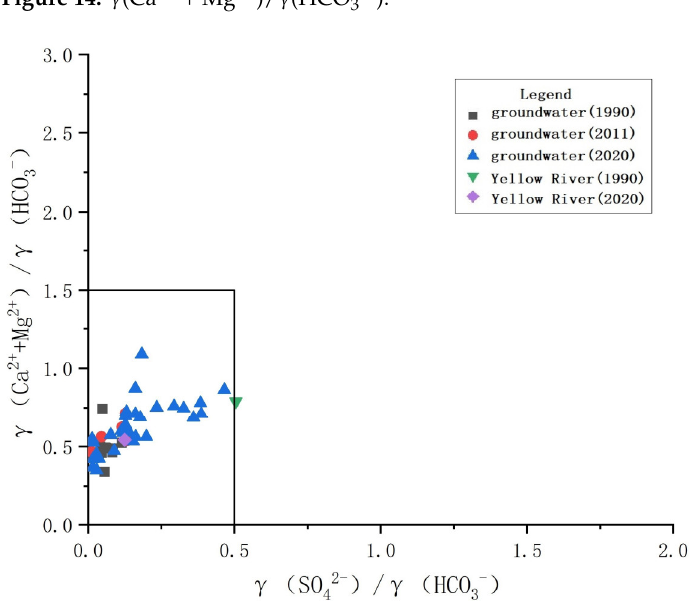
− ) and γ (SO 42 − )/ γ (HCO 3